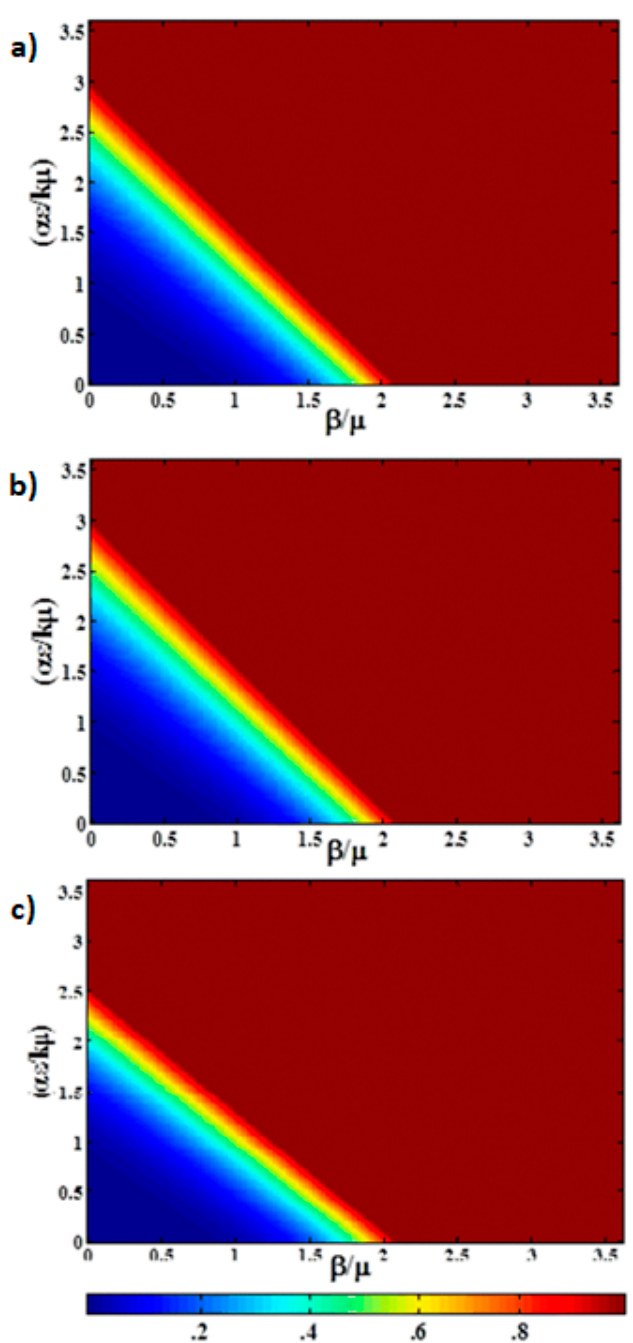
Figure 5. Sensitivity analysis of epidemiological parameters for indirect transmission at t = 100 days. The heat map shows the fraction of infectious as a function of R direct = range of epidemiological values listed as: ( a ) β = [ 0, 12 ] , (cid:15) = [ 0, 12 ] , k = 1, α = 0.1; ( b ) β = [ 0, 12 ] , (cid:15) = 0.1, k = 0.1, α = [ 0, 12 ] ; ( c ) β = [ 0, 12 ] , (cid:15) = [ 0, 24 ] , k = 2, α = 0.1